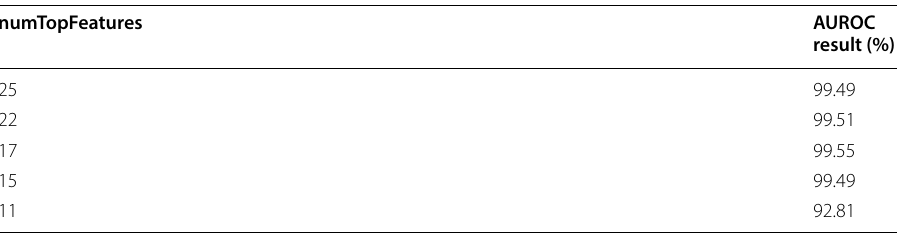
Table 4 AUROC result based on numTopFeatures